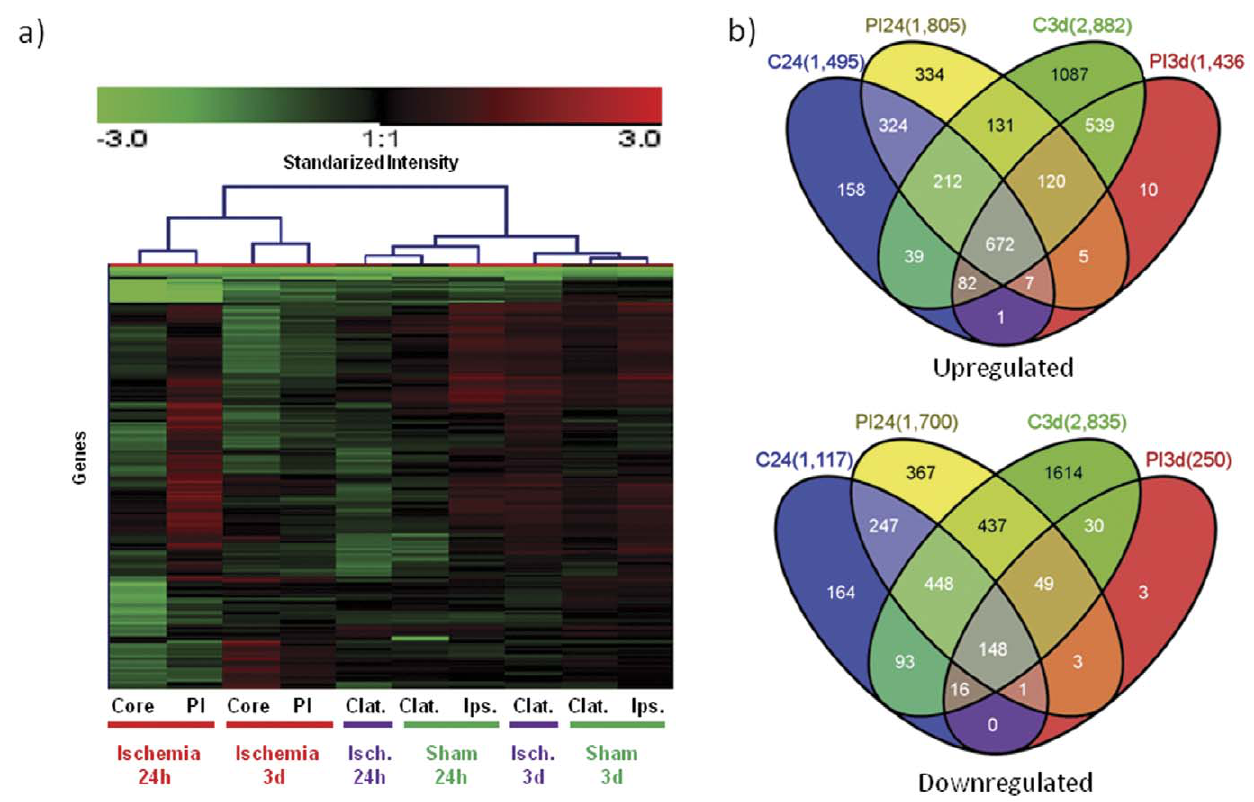
Figure 2. Focal cerebral ischemia induces early and delayed gene regulation with different patterns in core and periinfarct areas. RNA was isolated (Qiagen RNeasy) and hybridized to Agilent chips (4 6 44 K). (a) Upper part of the Heat map of the genes with an at least 2-fold change in expression in at least one condition after 24 h and 3 d of permanent cerebral infarct vs. levels in healthy samples. Each experimental condition is given at the bottom. PI=Periinfarct area; Clat=Contralateral cortex; Ips=Ipsilateral area. Vertical ‘‘Y’’ axis shows individual genes. Red=Up; Black=no change; Green=down. (b) Venn diagrams of upregulated and downregulated genes showing differences between core (C) and periinfarct (PI) at 24 h and 3 days of ischemia compared with healthy individuals (logFC=|1|; P , 0.05).